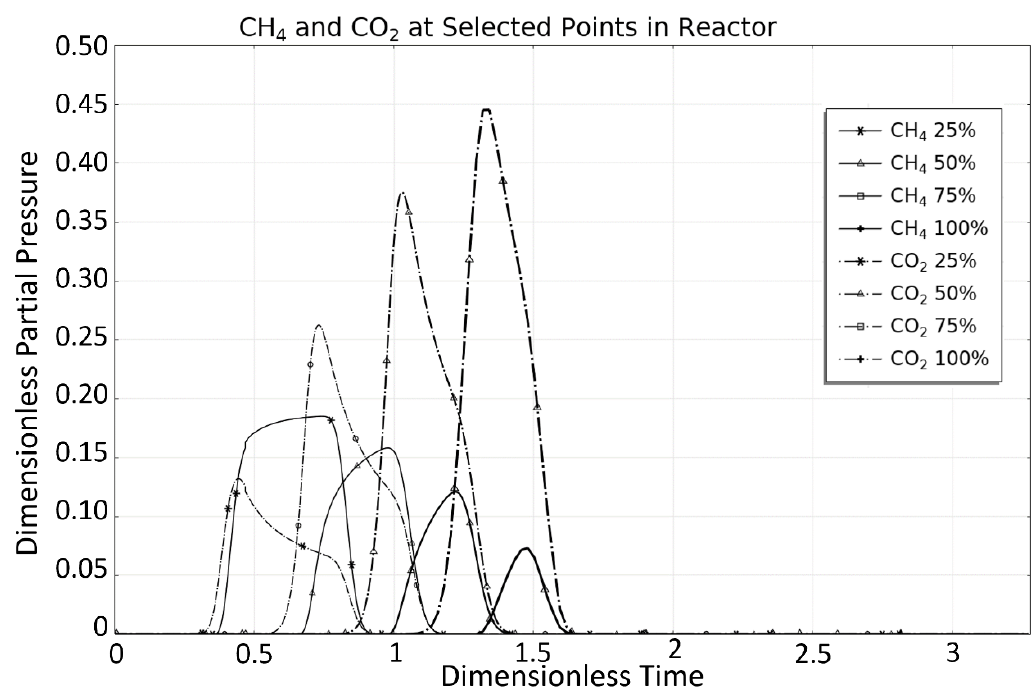
Figure 12. Dimensionless time evolution of CH 4 and CO 2 dimensionless partial pressure in void domain at four reactor lengths for the last cycle for Da = 4, Θ = 50.